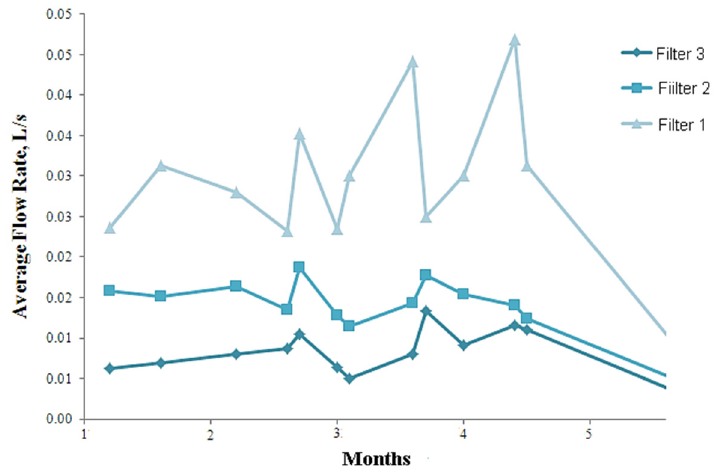
Figure 5. Average effluent flow rates during the period of May–September 2013 (After 1 year of